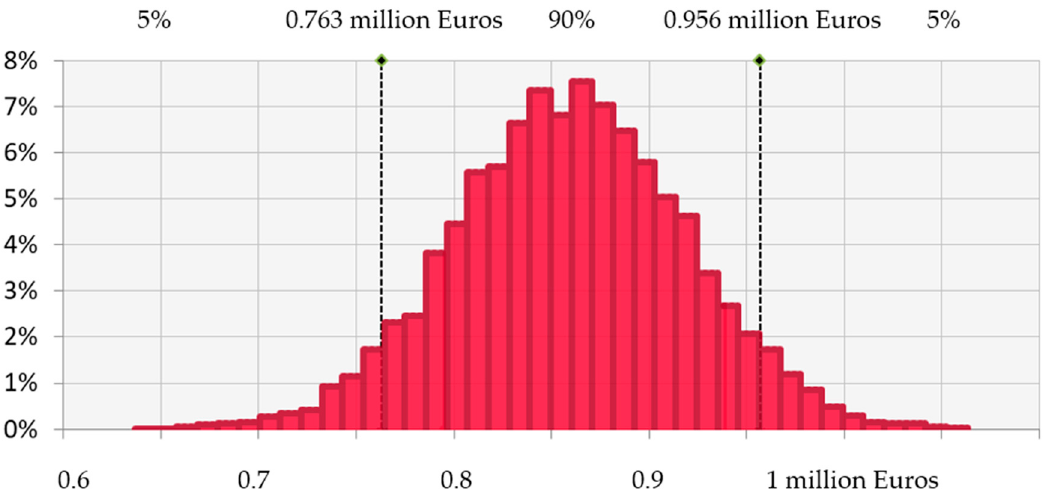
Figure 6. Distribution of the net present value in millions of Euros of one wind turbine with fluctuating full-load hours (peak performance of 3200 ± 500 h as a triangular distribution, 10,000 simulations with @RISK).